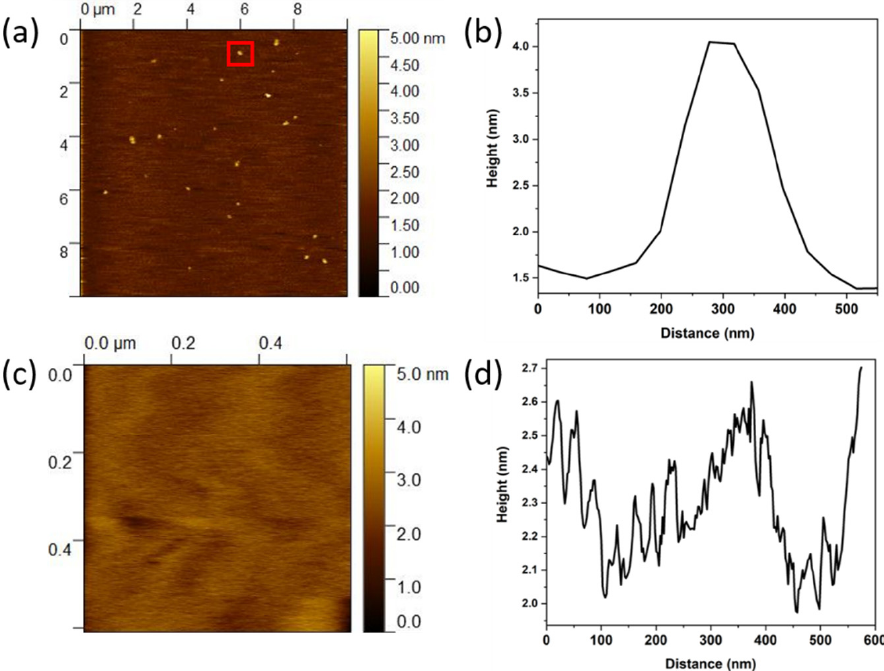
Figure 7. ( a ) AFM of a TRuCoTPyPz thin layer, dropcasted on a mica substrate, showing aggregates as bright spots; ( b ) cross-section of one of the aggregates; ( c ) AFM of the typical TRuCoTPyPz modified GC electrode used as the working electrode in the electrochemical measurements; ( d ) topographic profile of the TRuCoTPyPz electrode.